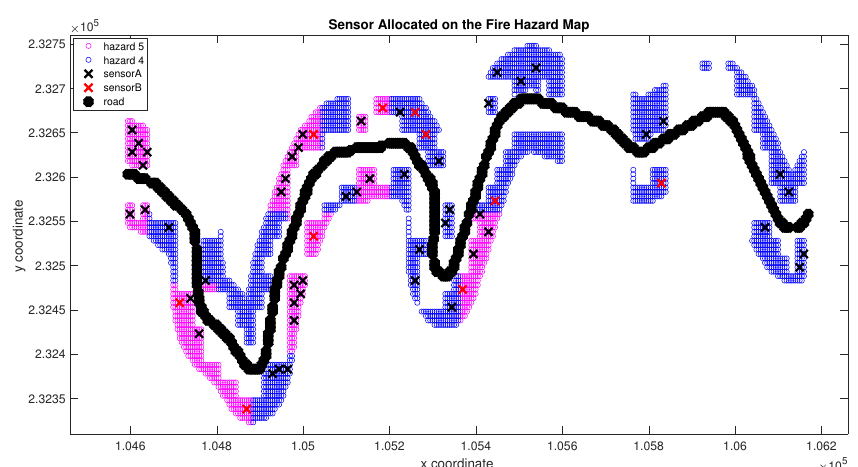
Figure 6. Optimum solution to spread sensor on Region 1. Table 3. Algorithm results for Region 2. Runs Obj. Func. Interactions Overlap